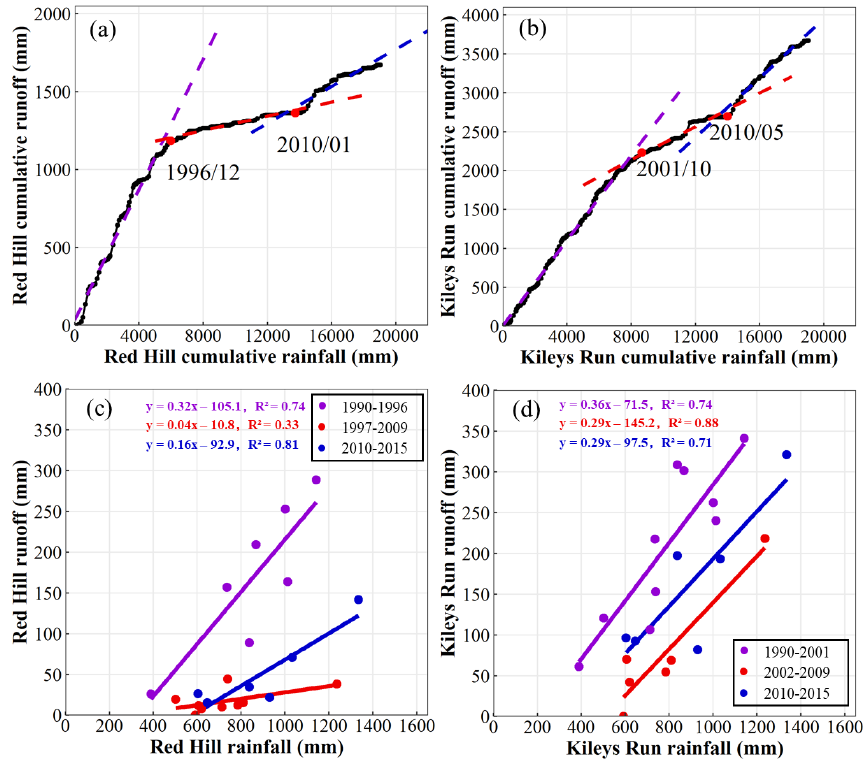
Figure 4. (a) Double mass curve of monthly rainfall and runoff of the Red Hill catchment (treated catchment), (b) double mass curve of monthly rainfall and runoff of the Kileys Run catchment (control catchment), (c) relationships between annual rainfall and runoff of the Red Hill catchment (treated catchment), and (d) relationships between annual rainfall and runoff of the Kileys Run catchment (control catchment). The dashed lines in (a) and (b) represent the linear regression lines between cumulative rainfall and cumulative runoff during three different periods – January 1990 to December 1996 (purple), January 1997 to January 2010 (red), and February 2010 to December 2015 (blue) in Red Hill; January 1990 to October 2001 (purple), November 2001 to May 2010 (red), and June 2010 to December 2015 (blue) in Kileys Run. The purple, red, and blue lines in (c) and (d) represent the linear regression lines for three different periods (1990–1996, 1997–2009,